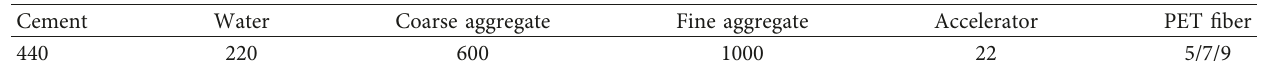
Table 3: Levels of variables used in orthogonal test.